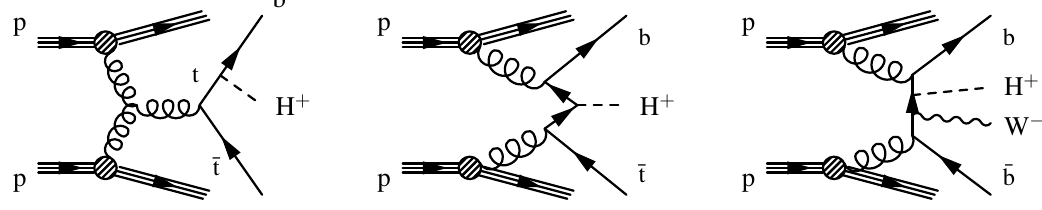
Figure 1 . Leading order diagrams describing charged Higgs boson production. Double-resonant top quark production (left) is the dominant process for light H (cid:6) , whereas the single-resonant top quark production (middle) dominates for heavy H (cid:6) masses. For the intermediate region ( m both production modes and their interplay with the nonresonant top quark production (right) must be taken into account. Charge-conjugate processes are